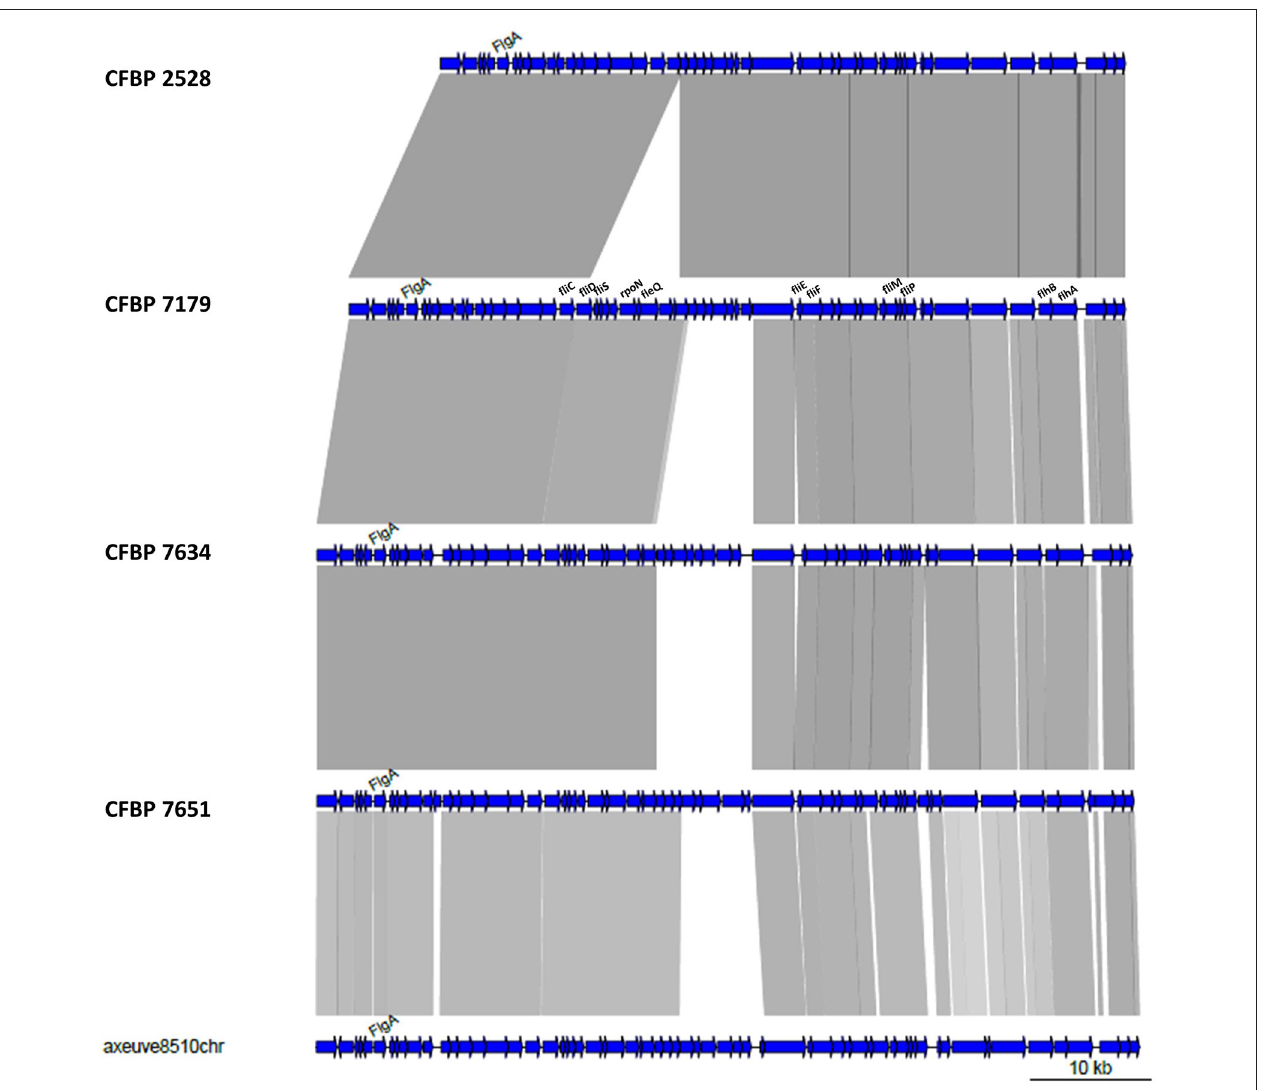
FIGURE 6 | Schematic representation of the flagellar gene cluster of the four X. arboricola strains.